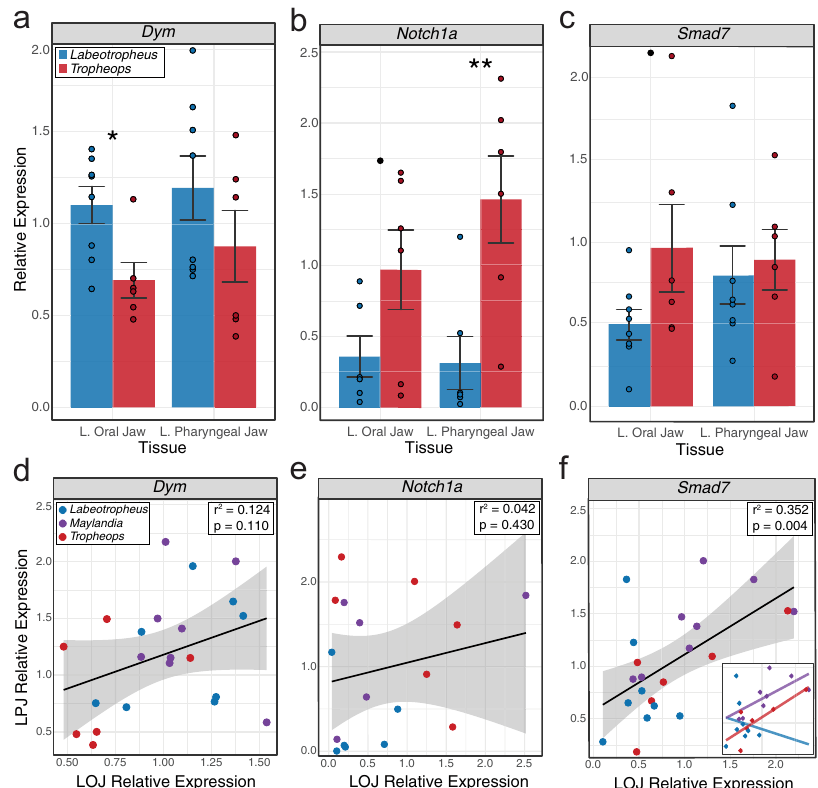
Fig. 5 Comparing expression levels of dym , smad7 , and notch1a via qPCR in the oral and pharyngeal jaws. a dym bar plot; ( b ) notch1a bar plot; ( c ), smad7 bar plot; ( d ), dym scatter plot; ( e ), notch1a scatter plot; ( f ), smad7 scatter plot. a – c bar plots depict mean relative expression levels, error bars denote standard error. d – f Scatterplots depict relative expression levels of the LOJ and LPJ, error bounds surrounding the linear regression line denote standard error. e inset, linear regression for each genus. Three cichlid taxa were included: Labeotropheus n = 8, Tropheops n = 6, Maylandia n = 8. Bar plot signi fi cance determined via t -tests: ● P < 0.10, * P < 0.05, ** P < 0.01. Source data are provided as a Source Data fi